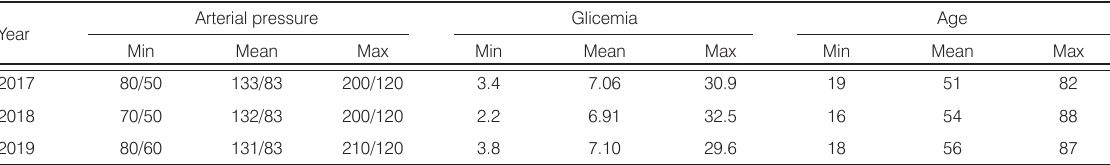
Table 1. The comparison in years (2017–2018–2019) for arterial pressure and glicemia measurements.